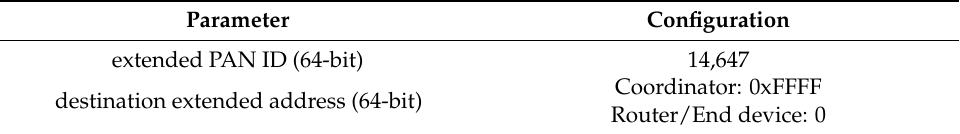
Table 1. IoT-Plug and Play (PNP) ZigBee network